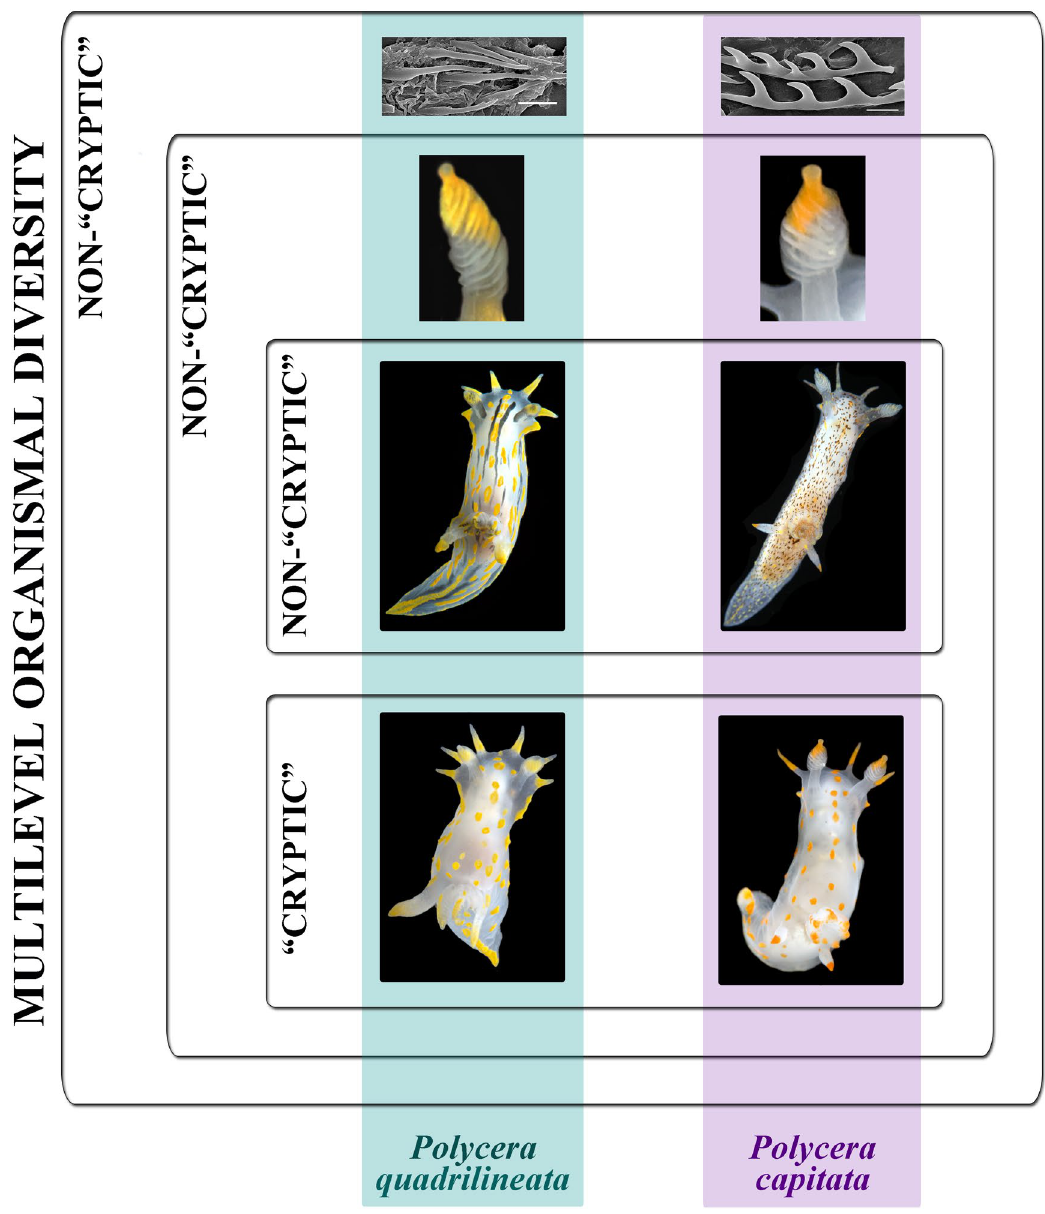
Figure 10. Presentation of the multilevel organismal diversity approach using the example of closely related Polycera quadrilineata and P. capitata : presence of conditional “non-cryptic” and putative “cryptic” components among the same species and provision of fine-scale morphological diagnostic characters even among the “cryptic component” within a single species. Scale bars—10